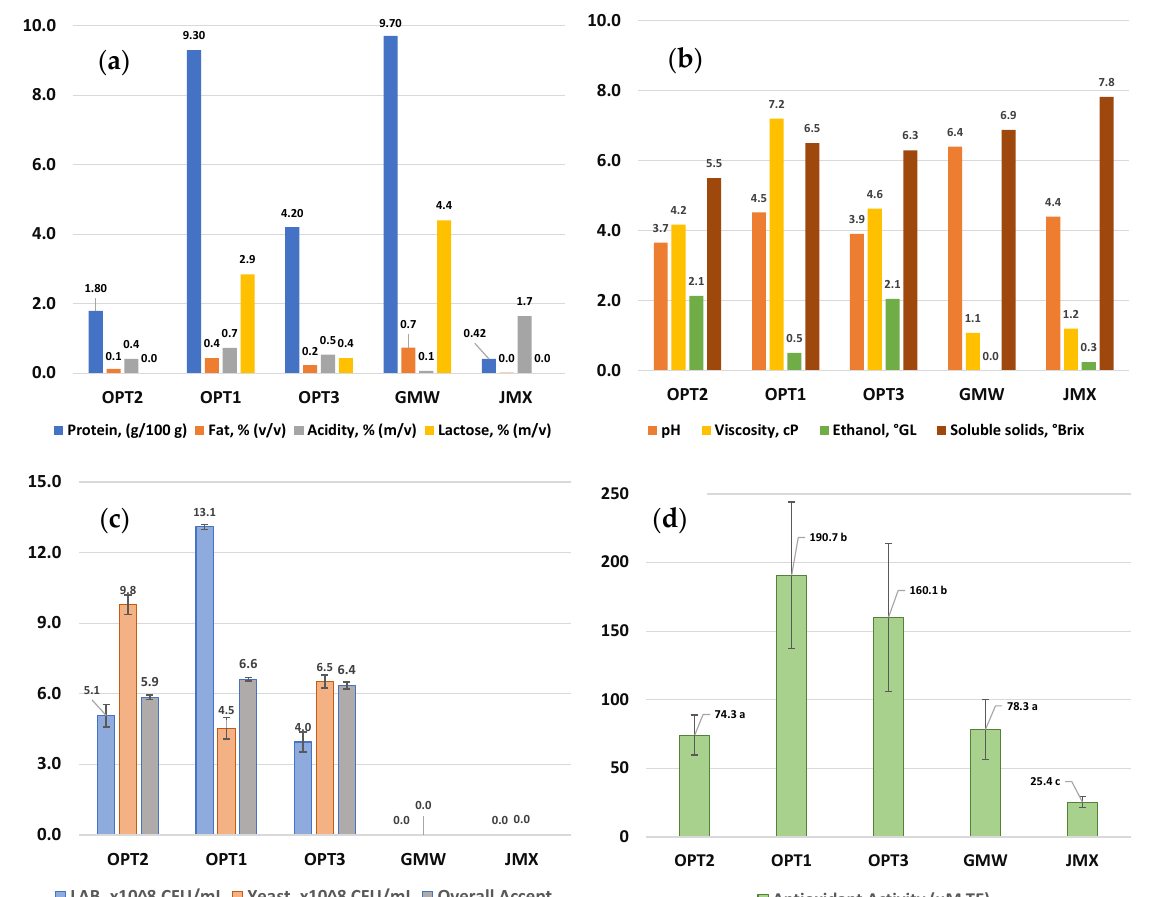
Figure 5. Values of the physical-chemical, nutritional, and microbiological properties, of the three candidates for functional fermented beverages produced under optimal conditions OPT1, OPT2, and OPT3, and the raw materials used in their preparation (GMW and JMX). ( a ) Nutritional properties (n = 1) protein content (g/100 g), fat (% v / v ), lactose (% m / v ) and acidity (% m/m); ( b ) Chemical- physical properties (n = 1) pH, viscosity (cP) and ethanol content (°GL) and soluble solids (°Brix); ( c ) Probiotic and global acceptability properties (n = 5) LAB and yeast counts (CFU/mL) and assess- ment of global acceptability (-); and ( d ) Antioxidant Activity (n = 3), expressed in µM of Trolox equivalent (TE). Different letters represent significant statistical differences ( α < 0.05).